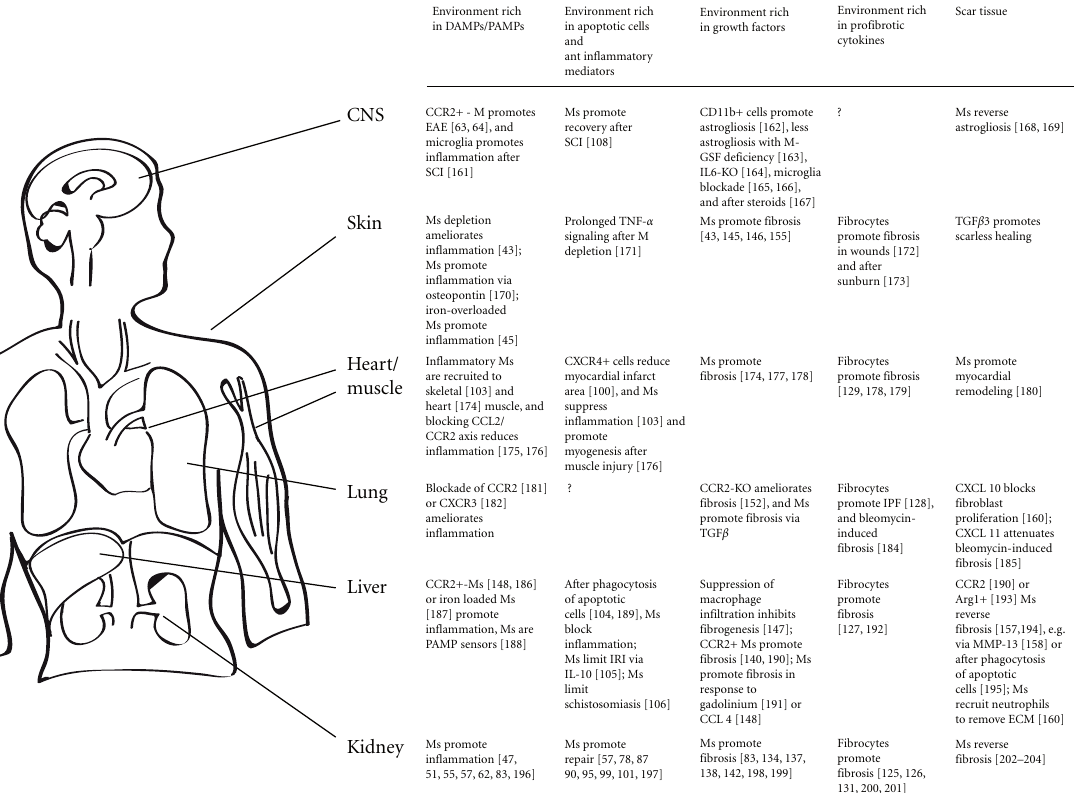
Figure 3: Macrophages in di ff erent phases of solid organ